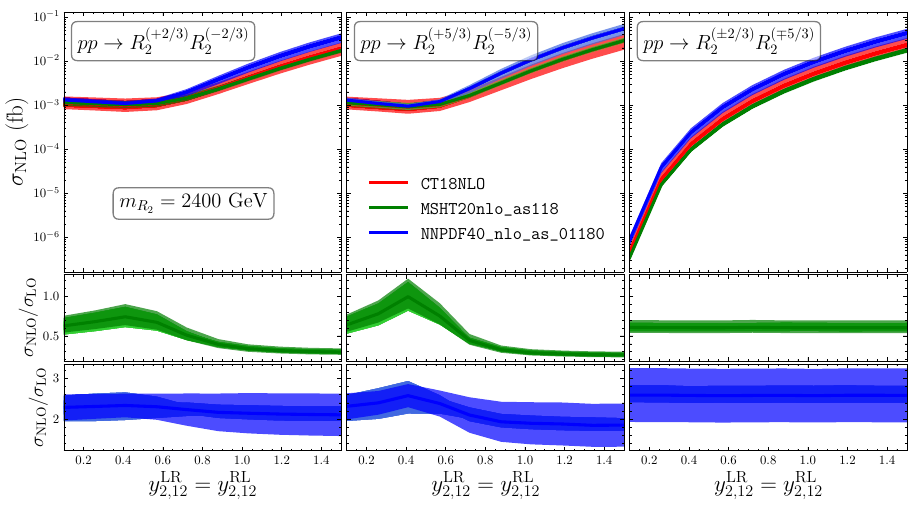
Figure 9 . Same as in figure 2 but for m R